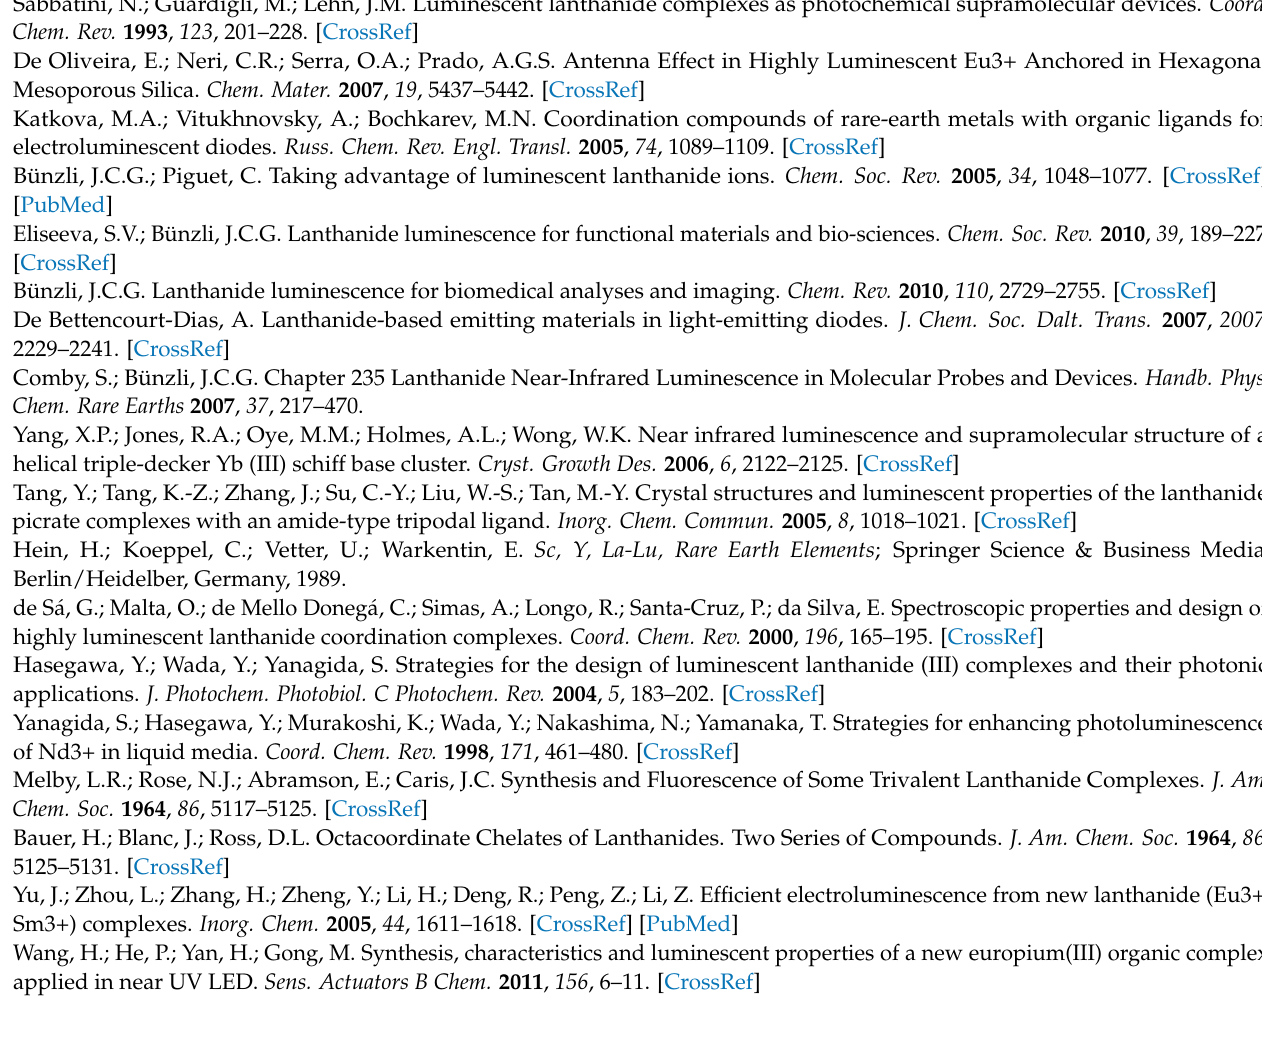
Figure S6: Normalized intensity and lifetime of luminescence plotted for the composite films doped with different content of the Eu(III) complex as the functions of UV irradiation time; Figure S7: Cyclic dependences of luminescence intensity and lifetime of the composite film doped with 20 wt% Eu(III); Figure S8: Photos of the 3D-printed PLA composites doped with 2.5 wt% of the Eu(III) complex in visible and UV light; Table S1: Quantum efficiency of luminescence ( Φ Ln ) of samples and